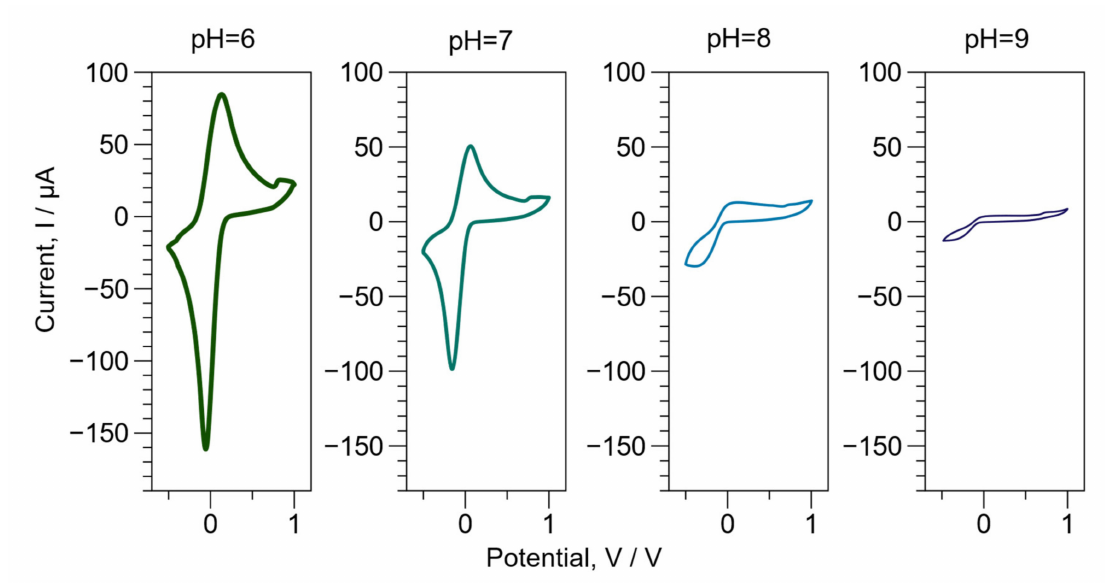
Figure 8. Electroactivity properties as a function of pH (6 to 9) by cyclic voltammetry of the BL